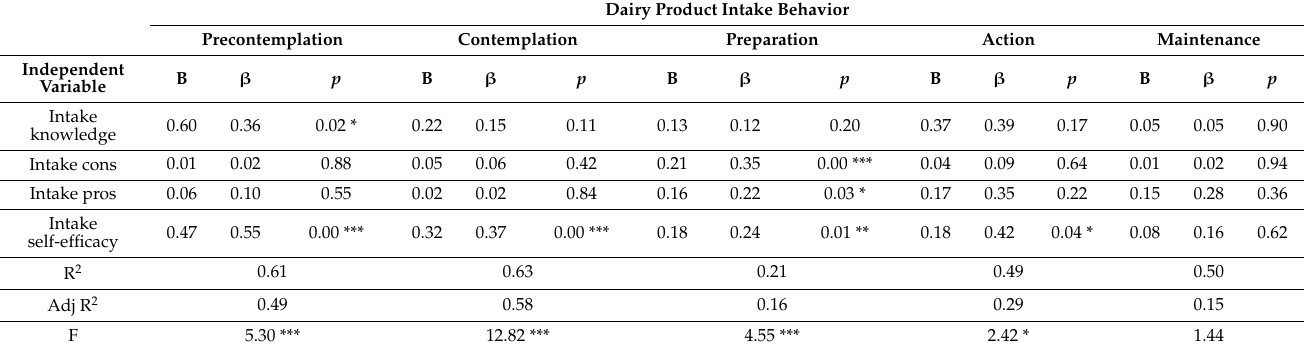
Table 5. Multiple regression analysis of dairy product intake behavior among stages of change (n =